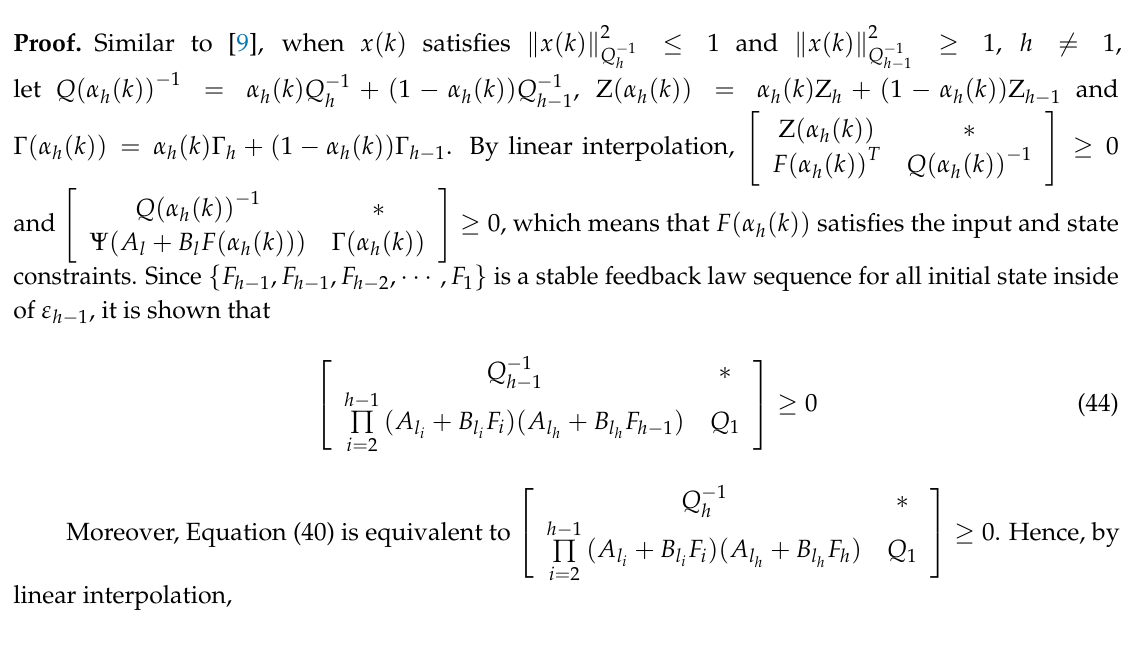
Algorithm 2 robustly asymptotically stabilizes the closed-loop